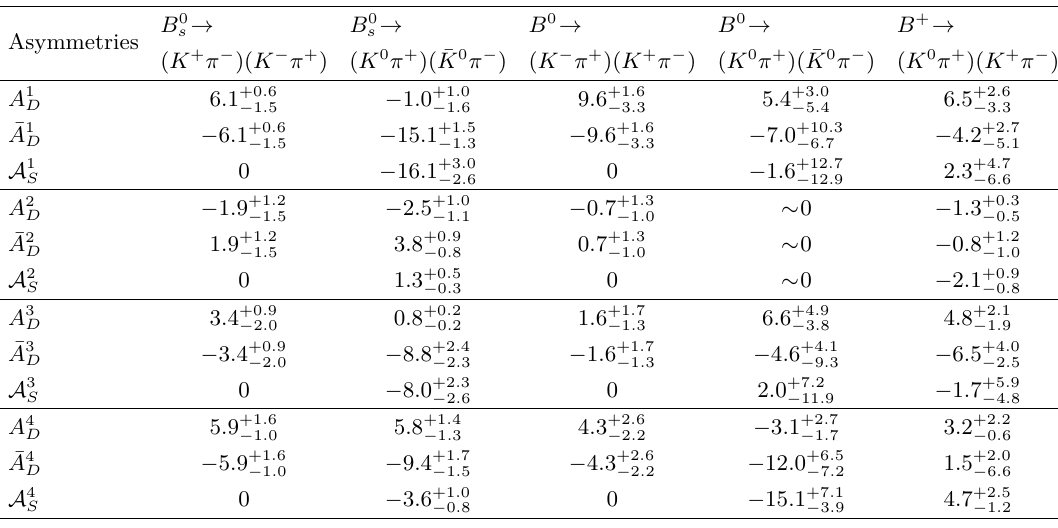
Table 7 . PQCD predictions for the asymmetries ( % ) from the interference with the amplitude A and for the S -wave-induced direct CP asymmetries ( % ) of the considered decays in the Kπ S + invariant mass window of 150 MeV around the K ∗ (892)